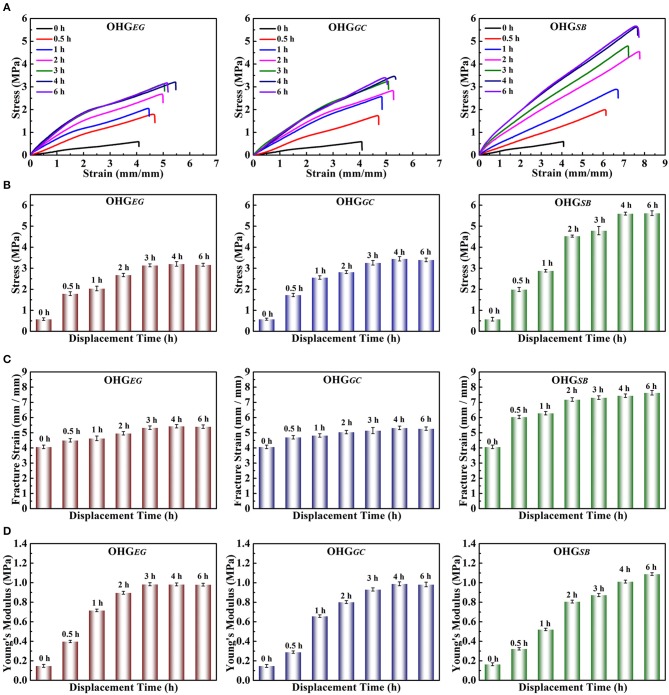
Mechanical properties of the Eu-alginate/PVA organohydrogels (OHGEG, OHGGC, OHGSB) treated with cryoprotectants for different times. (A) stress-strain curves, (B) stress-displacement time histogram, (C) Fracture strain-displacement time histogram, (D) Young's modulus-displacement time histogram.